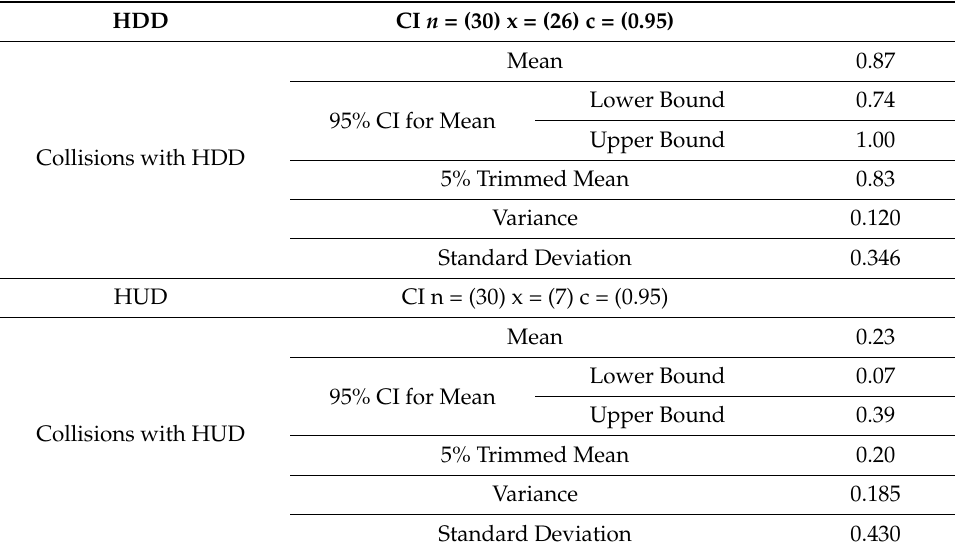
Table 1. Probability of collision occurrences for HDD and HUD with CI 95%.